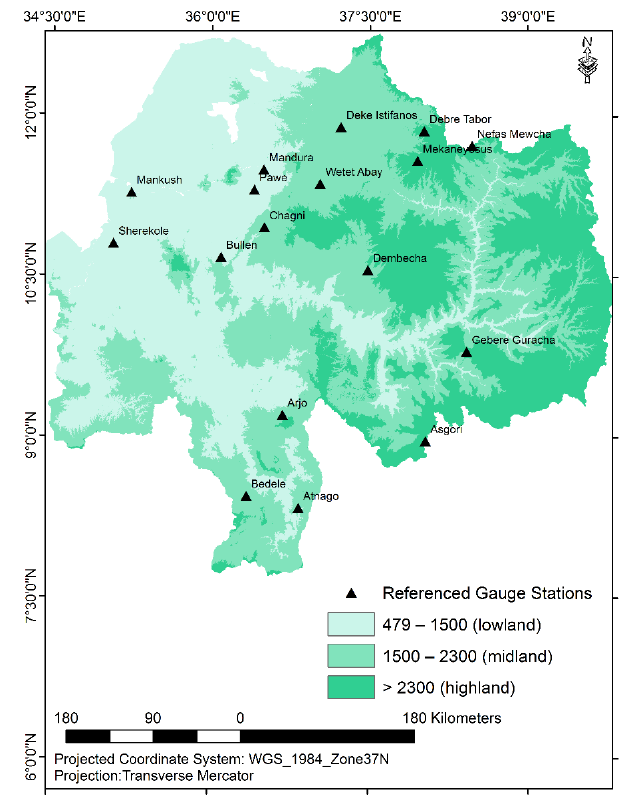
Figure 2. The distribution of referenced gauge stations over the elevation zones of the Upper Blue Nile